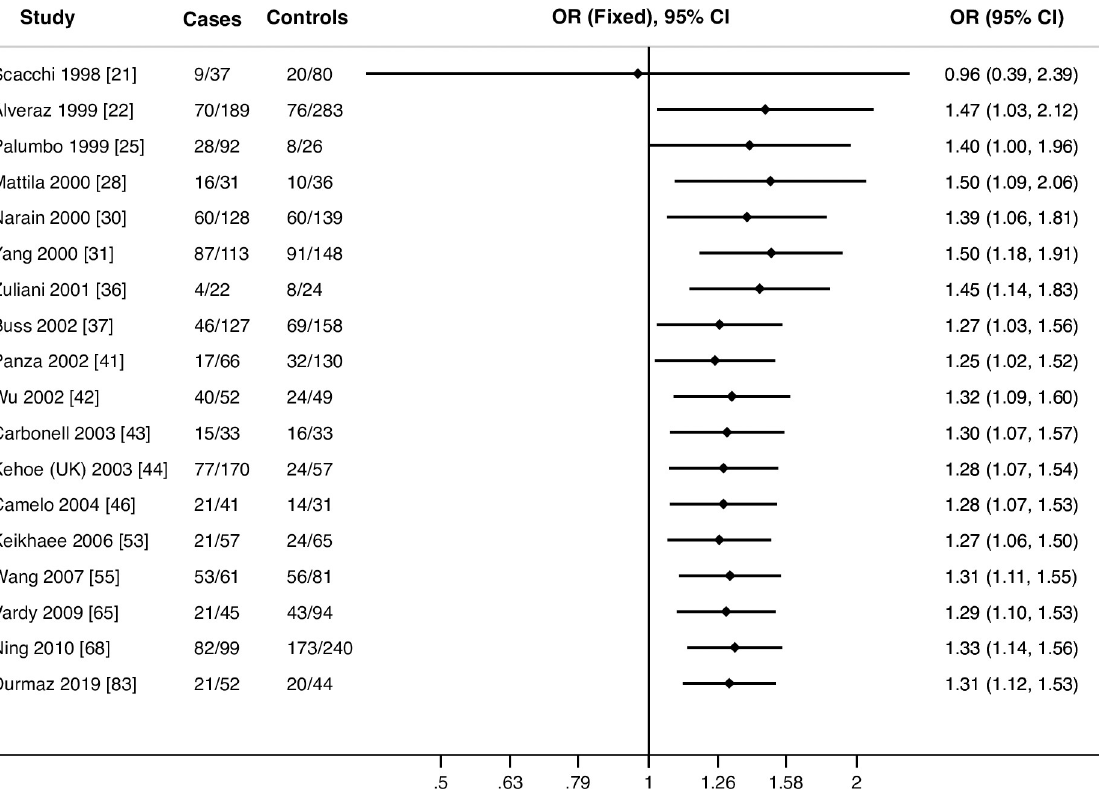
Fig 3. Cumulative meta-analysis of the relation between ACE rs1799752 I / D polymorphism and late-onset AD susceptibility ( II vs DD ). Each study was used as an information step. The vertical dotted line is the summary odds ratio. Bars, 95% confidence interval (CI).